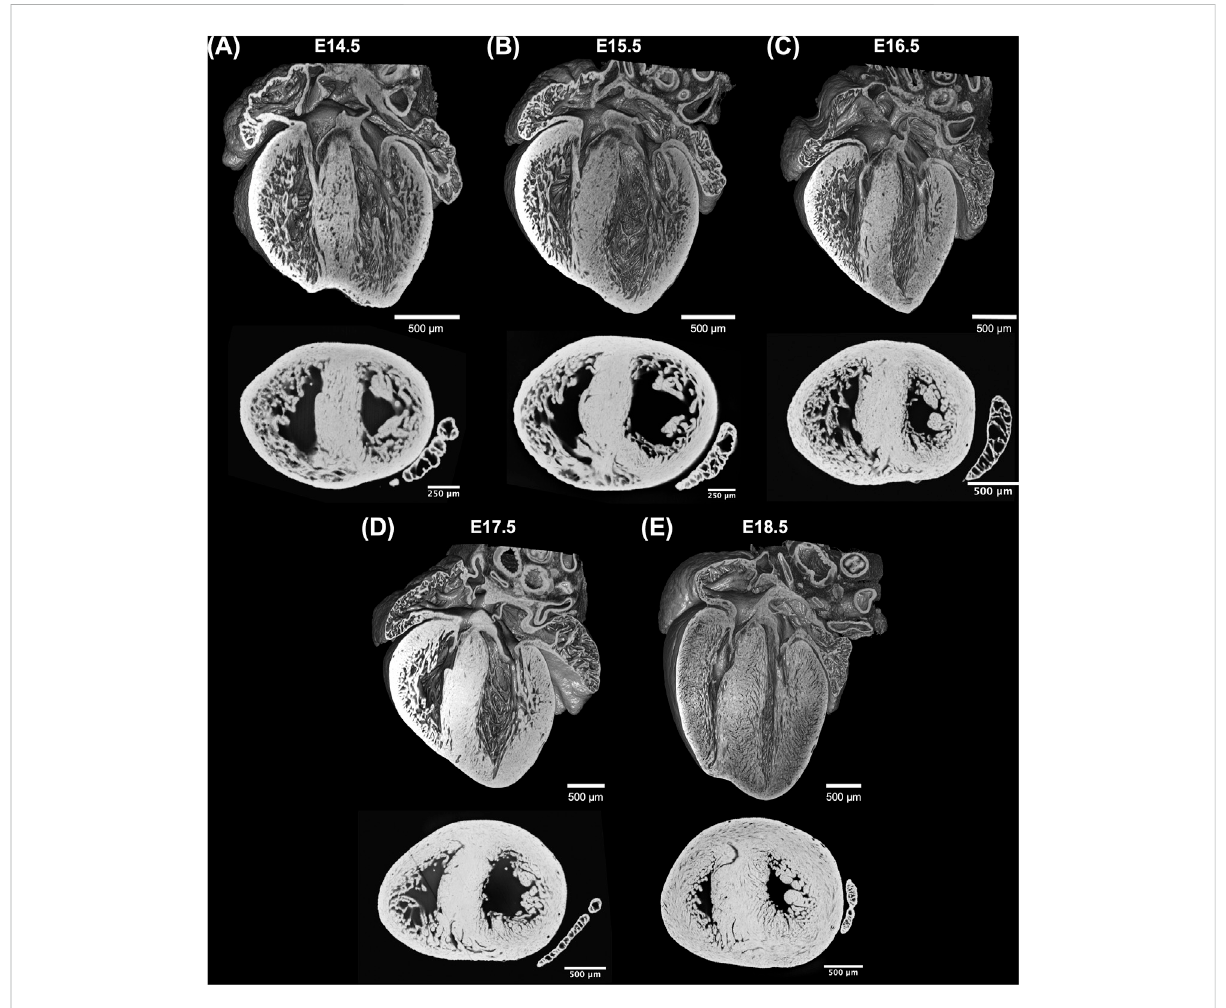
FIGURE 1 Whole-heart volume-rendered three-dimensional high-resolution episcopic microscopy reconstruction of the developing murine heart at (A) E14.5, (B) E15.5, (C) E16.5, (D) E17.5 and (E) E18.5 days, together with black/white inverted original episcopic microscopy 2D